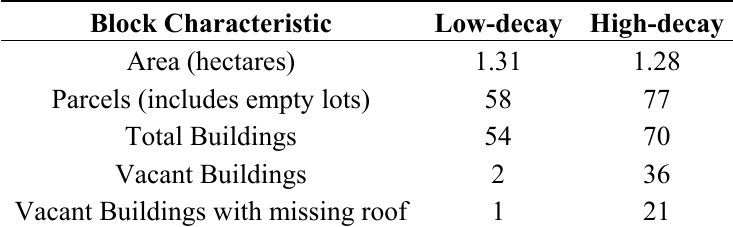
Table 1. Block-level